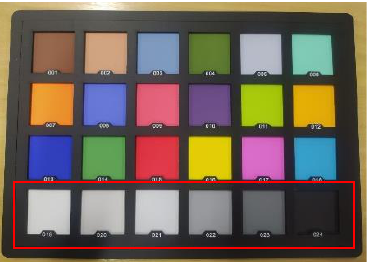
Figure 2 . X-rite Classic 24 panel with greyscale highlighted.